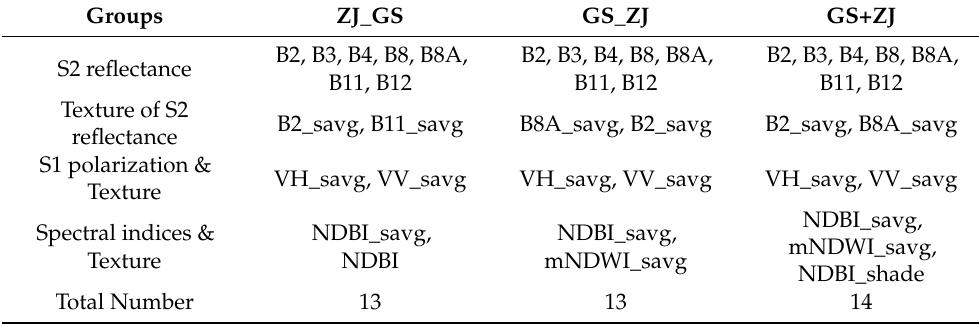
Table 5. Selected features used in different classification